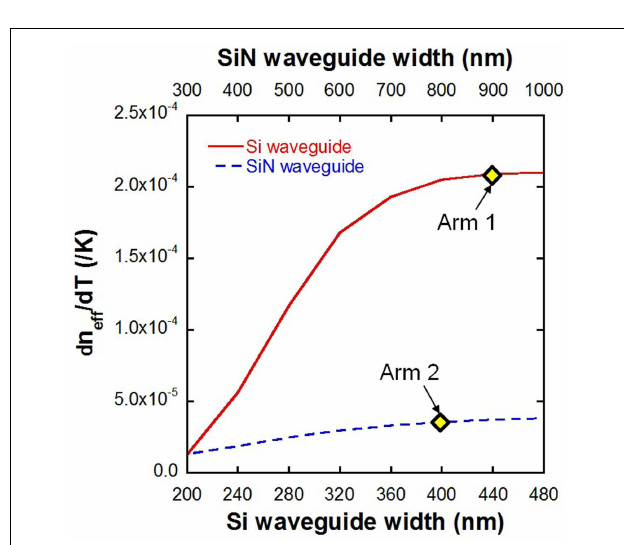
FIGURE 2 | Relationships between dn eff /dT and core width of Si and SiN waveguides .